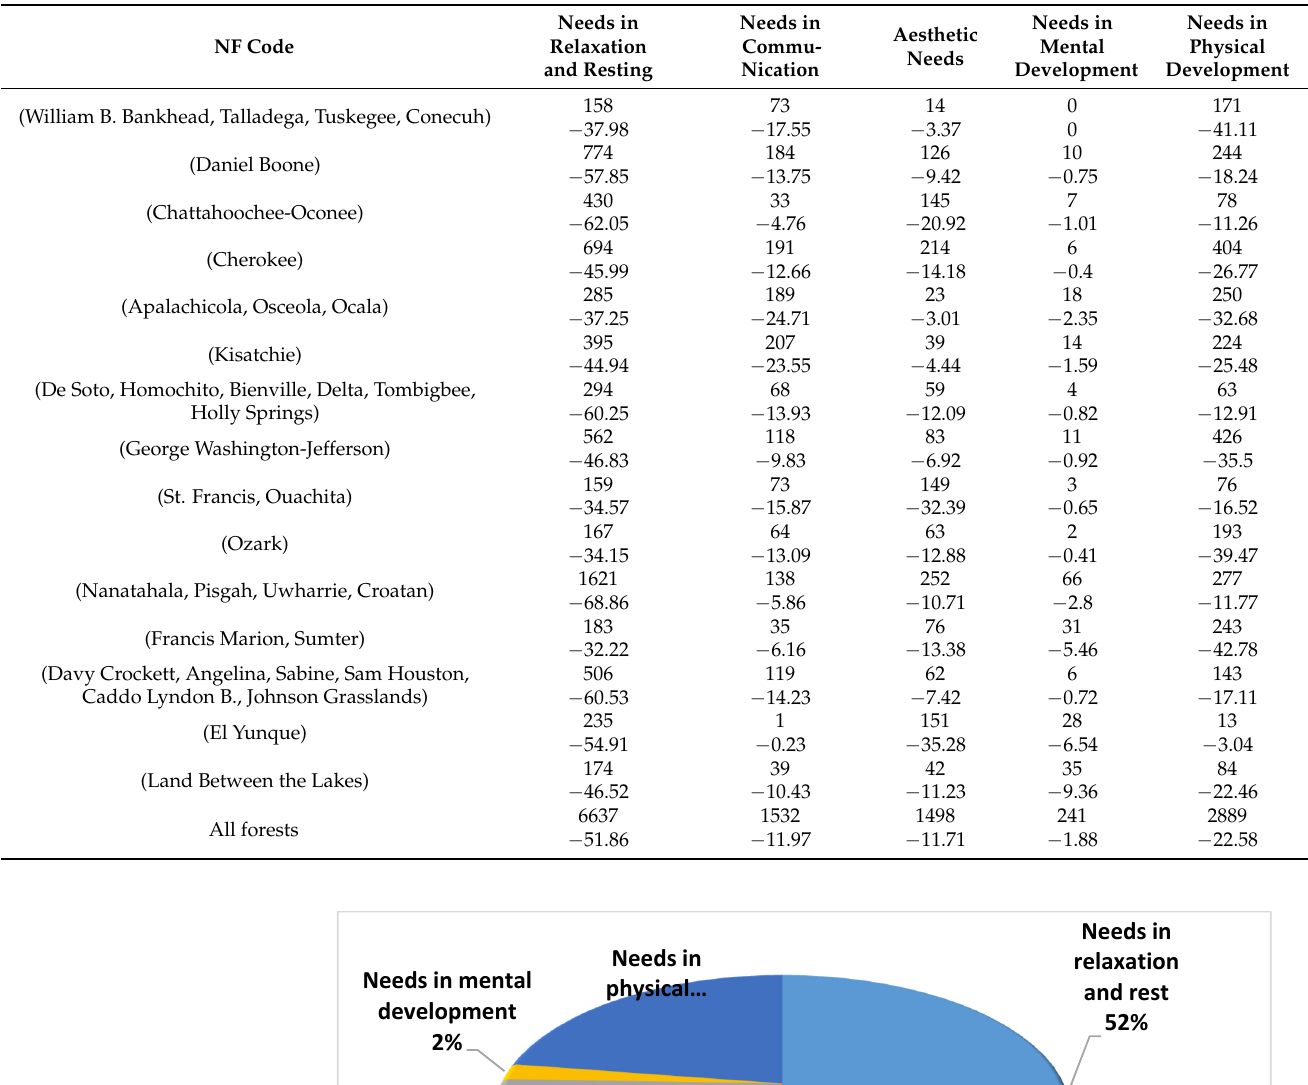
Table 4. Main drivers for recreation activities across forests (all visitors).